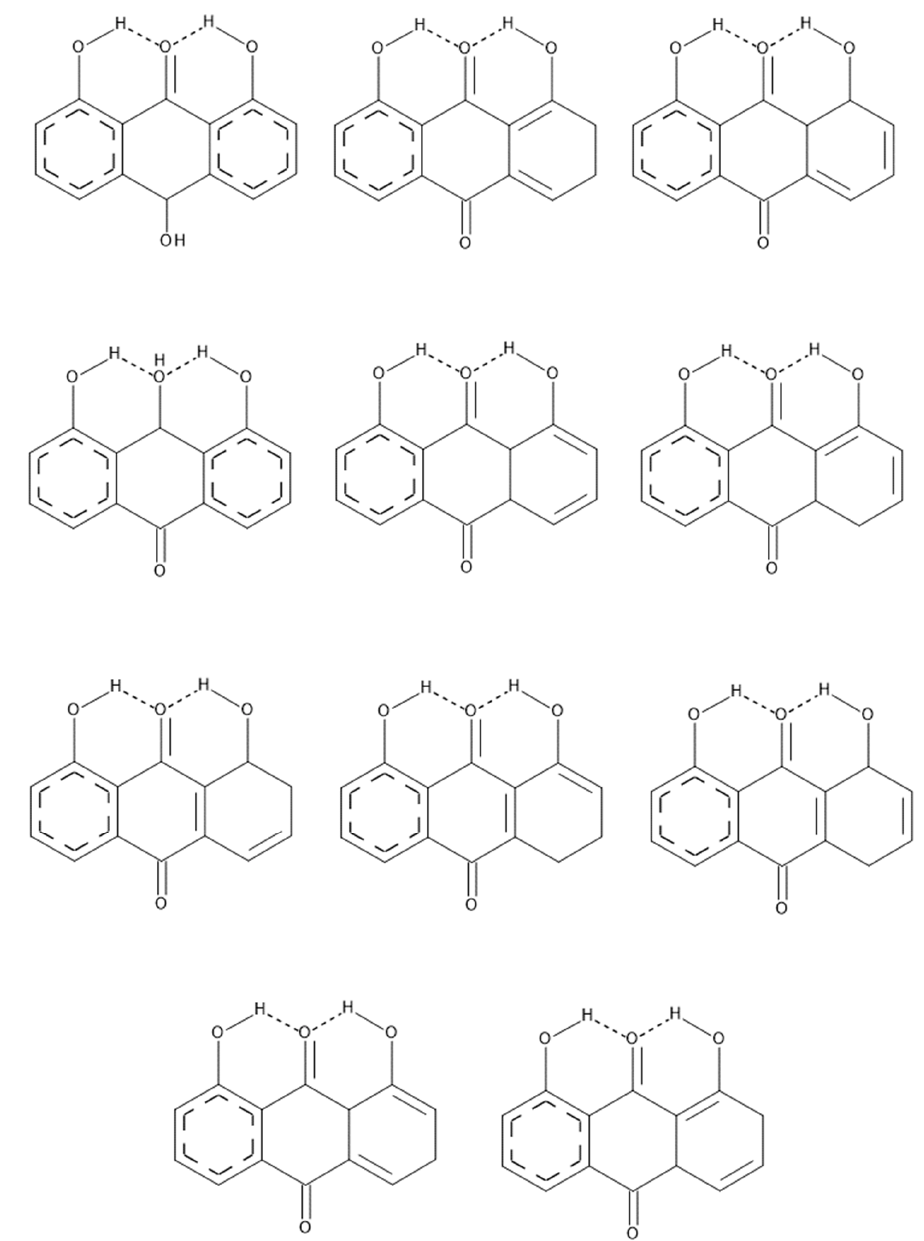
Figure 3. Possible prototropic forms for OH-substituted anthrone. Investigation of the Substituents Effect on BDE (O-H) and BDE (C-H) Table 5 shows the thermodynamic data for the tautomerization reaction. BDE